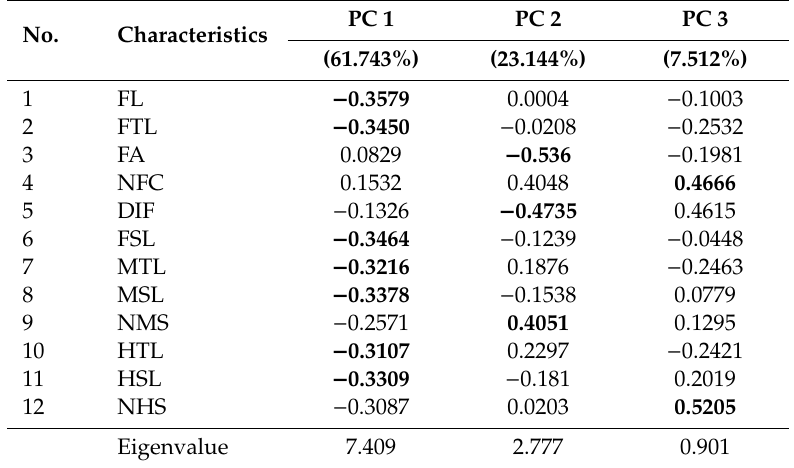
Figure 6. Principal component analysis (PCA) with twelve quantitative variables of cicada leg morphology for four species. FL, fore femur length; FTL, fore tibiae length; FA, femoral tooth angle; NFC, number of femoral comb teeth; DIF, distance between the intermediate tooth of the femur and last tooth of the femoral comb; FSL, pretarsus length; MTL, mesotibia length; MSL, mesotarsus length; NMS, number of mesotibial spines; HTL, metatibia length; HSL, metatarsus length; NHS, number of metatibial spines. filled circle, Cryptotympana atrata ; filled triangle, Hyalessa maculaticollis ; filled square, Meimuna opalifera ; open circle, Platypleura kaempferi . Table 2. Summary of the results of a principal component analysis of the twelve quantitative leg morphological characteristics of four species of Korean cicadas.